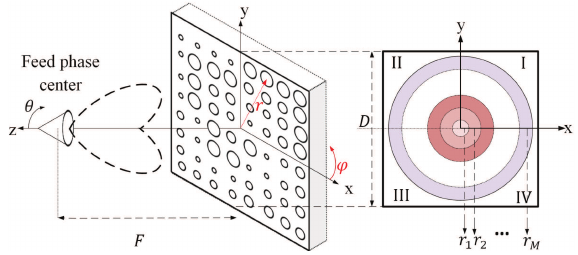
Figure 1: Topology of the proposed HPM reflectarray an- tenna.